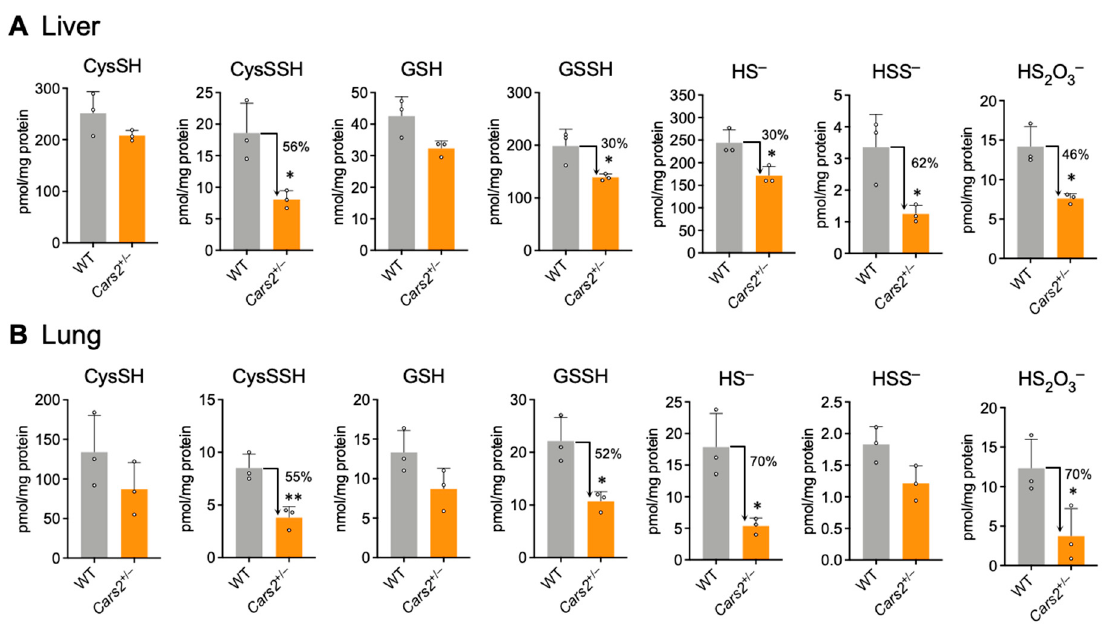
Figure 4. Sulfur metabolome analysis in Cars2 +/ − mice. Endogenous levels of sulfur metabolites were identi fi ed as those of HPE-IAM adducts by using LC–MS/MS analysis of liver ( A ) and lung ( B ) tissues of 10- to 16-week-old WT and Cars2 +/ − mice. Data are means + s.d. n = 3. * p < 0.05; ** p < 0.01, determined by Student’s t -test.